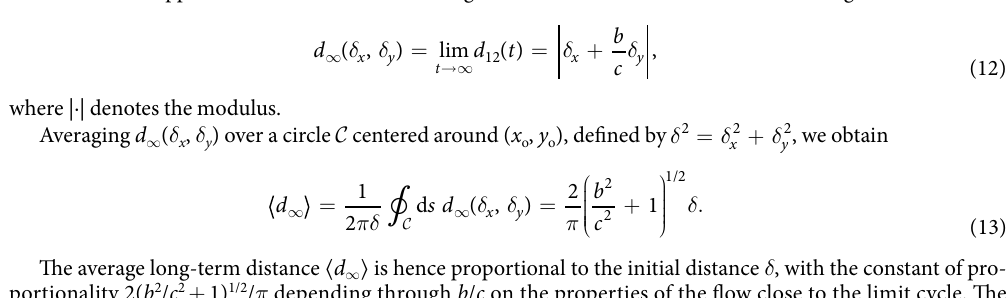
( , ) The average long-term distance 〈 d ∞ 〉 is hence proportional to the initial distance δ , with the constant of pro- portionality 2( b 2 / c 2 + 1) 1/2 / π depending through b / c on the properties of the flow close to the limit cycle. The factor b / c can be smaller or larger than unity, implying that the long-term distance of the two trajectories may exceed the initial distance. The normal form (9) describes the local flow close to a limit cycle. For the case of a non-uniform base velocity a = a ( x ) one need to generalize (13) by averaging over full periods. Choice of initial distances.